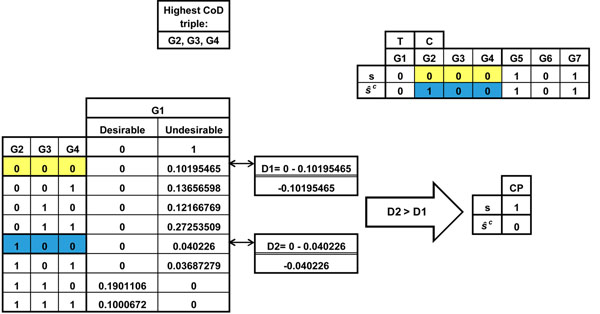
Deriving CoD-CP for a small 7-gene network. The x1 and x2 genes are the T and C genes, respectively. x1 = 0 defines Desirable states. The MAXCOD genes are: {x2, x3, x4}. The control action for state s is 1 and the control action for state  is 0, because D(2) >D(1).